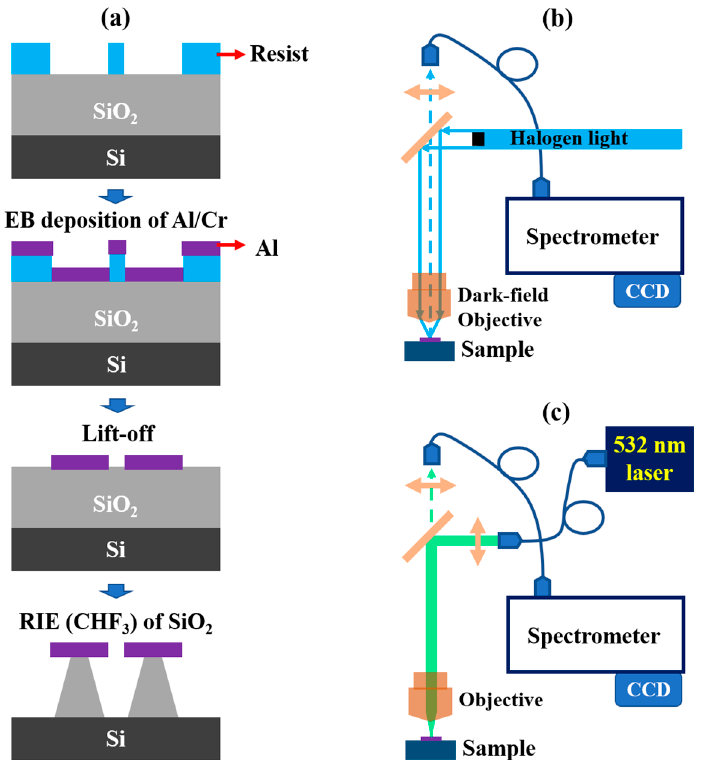
Figure 1. ( a ) Schematic illustration of the fabrication process. Optical microscopy setup of ( b ) dark-field measurement and ( c ) Raman measurement.